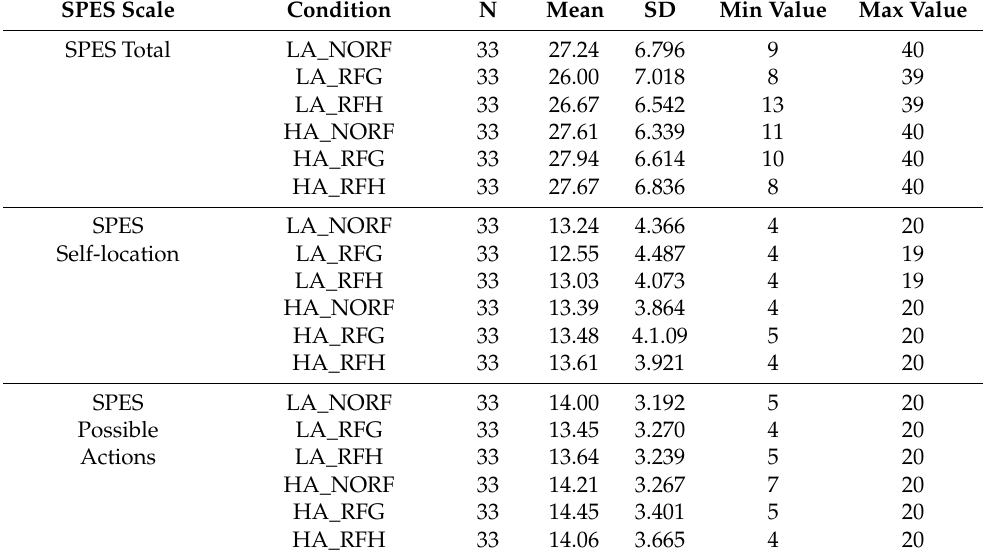
Table 8. Subjective presence levels assessed by the Spatial Presence Experience Scale (SPES) Questionnaire.